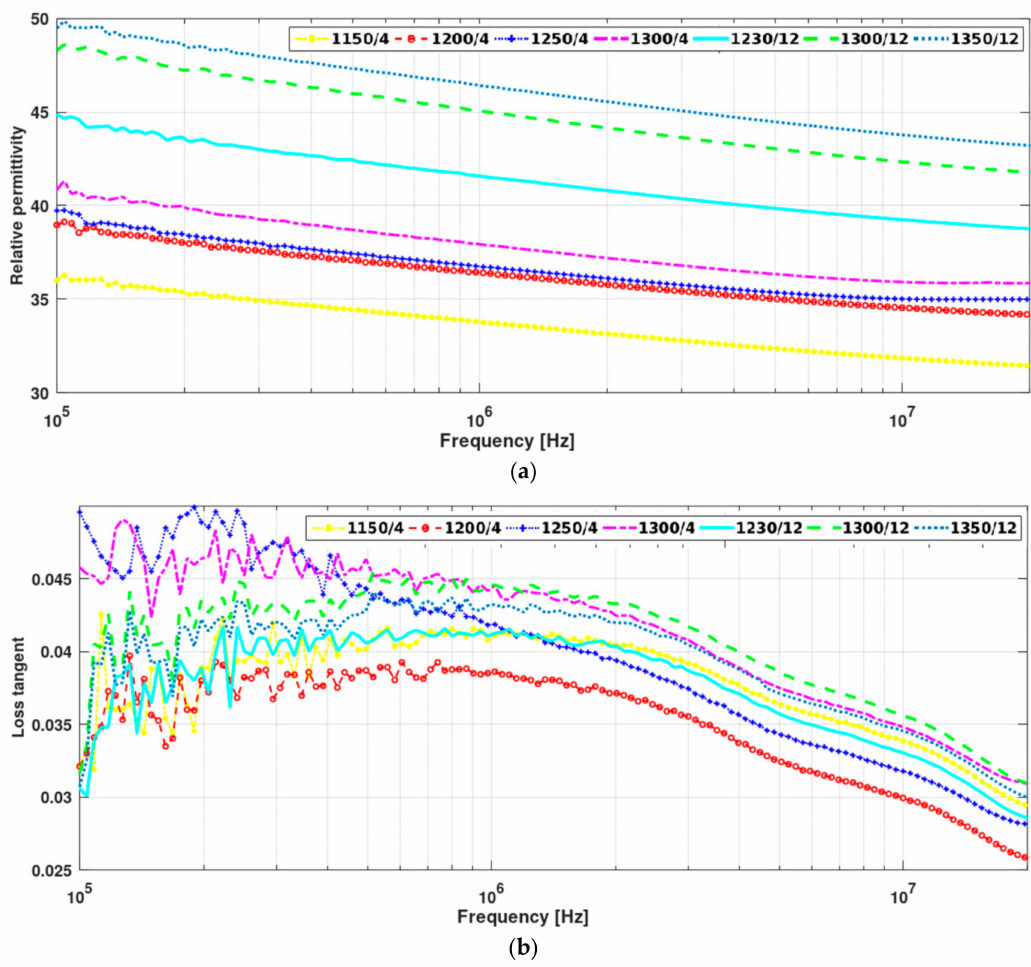
Figure 4. ( a ) Substrates relative dielectric permittivity and ( b ) loss tangent for TiO 2 samples sintered at di ff erent temperatures and times. Table 4. Dielectric permittivity, at di ff erent frequencies, for samples sintered at di ff erent conditions. Sample Frequency 1150 /